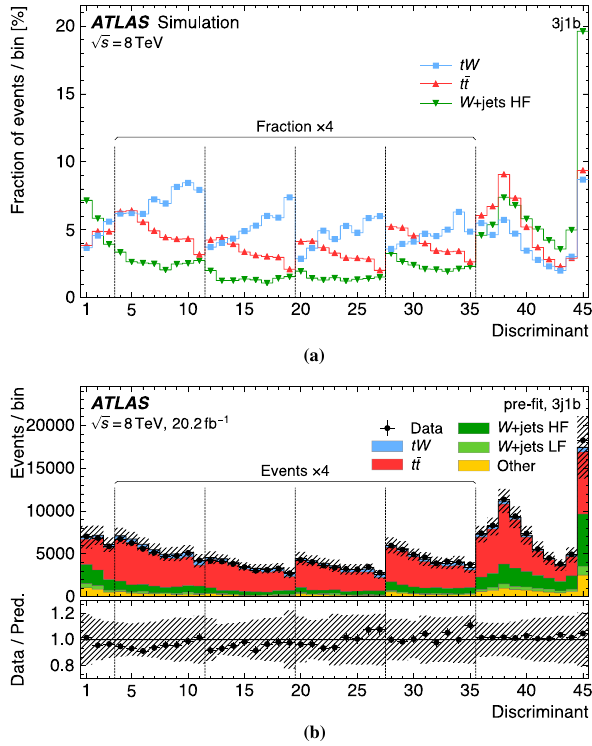
Fig. 6 a Shape distribution of the reconstructed discriminant in the tW signal (3j1b) region rearranged onto a one-dimensional distribu- tion. The distribution for each process normalised to unity is shown. b Pre-fit distributions of the discriminant in the tW signal (3j1b) region. Small backgrounds are subsumed under ‘Other’. The simulated distri- butions are normalised to their theoretical cross-sections. The dashed uncertainty band includes statistical and systematic uncertainties. The lower panels show the ratio of the observed and the predicted number of events in each bin. The first three bins and the last ten bins correspond directly to (non-uniform) bins of m ( W H ) . In between are four blocks of eight bins, corresponding to the NN output in slices of m ( W H ) .